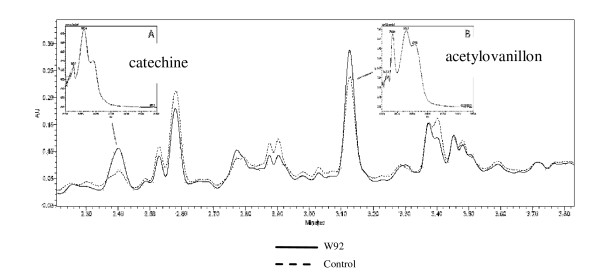
UPLC Identification of compounds in NaOH hydrolisate of flax fibres obtained from W92 and control plants. Chromatogram was registered at 280 nm.